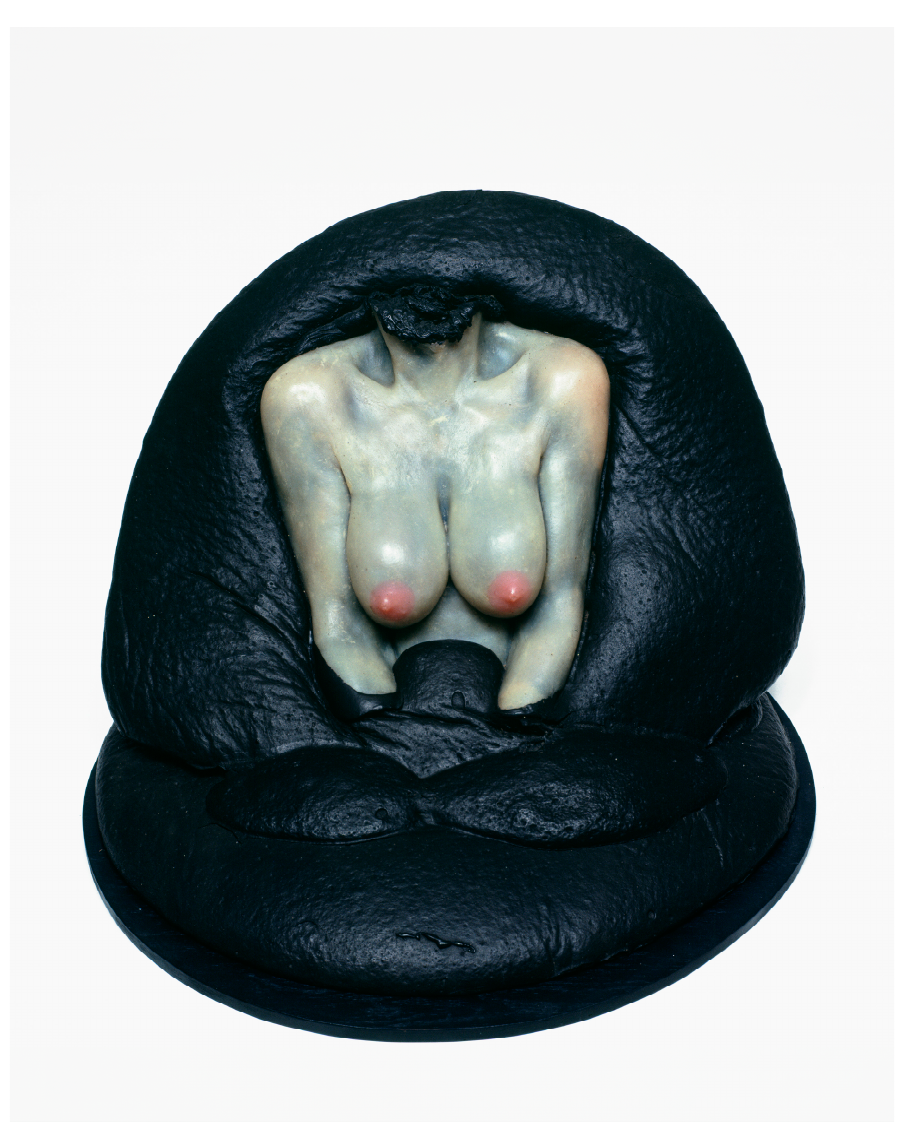
Figure 2. Alina Szapocznikow, Headless Torso , 1968, polyester resin and polyurethane foam, 46 × 64 × 73 cm, Zach˛eta National Gallery of Art, Warsaw © ADAGP, Paris. Courtesy of The Estate of Alina Szapocznikow/Piotr Stanislawski/Galerie Loevenbruck, Paris/Hauser &